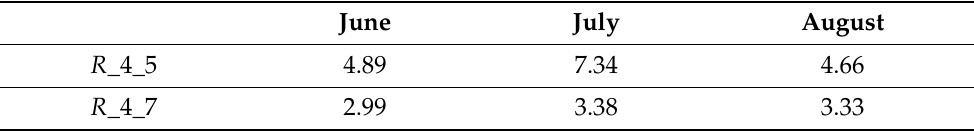
Table 4. Mean daily DTW between hourly outgoing and incoming curves in June, July and August, 2018.